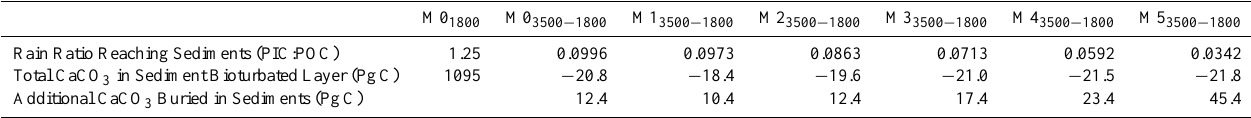
Table 5. Summary of the change in rain ratio and sediment output for years 1800–3500 for Suite M simulations. Values in column M0 1800 represent absolute output in the base model in year 1800. Subsequent columns show differences from 1800 to 3500 for each calcification sensitivity (M0 to